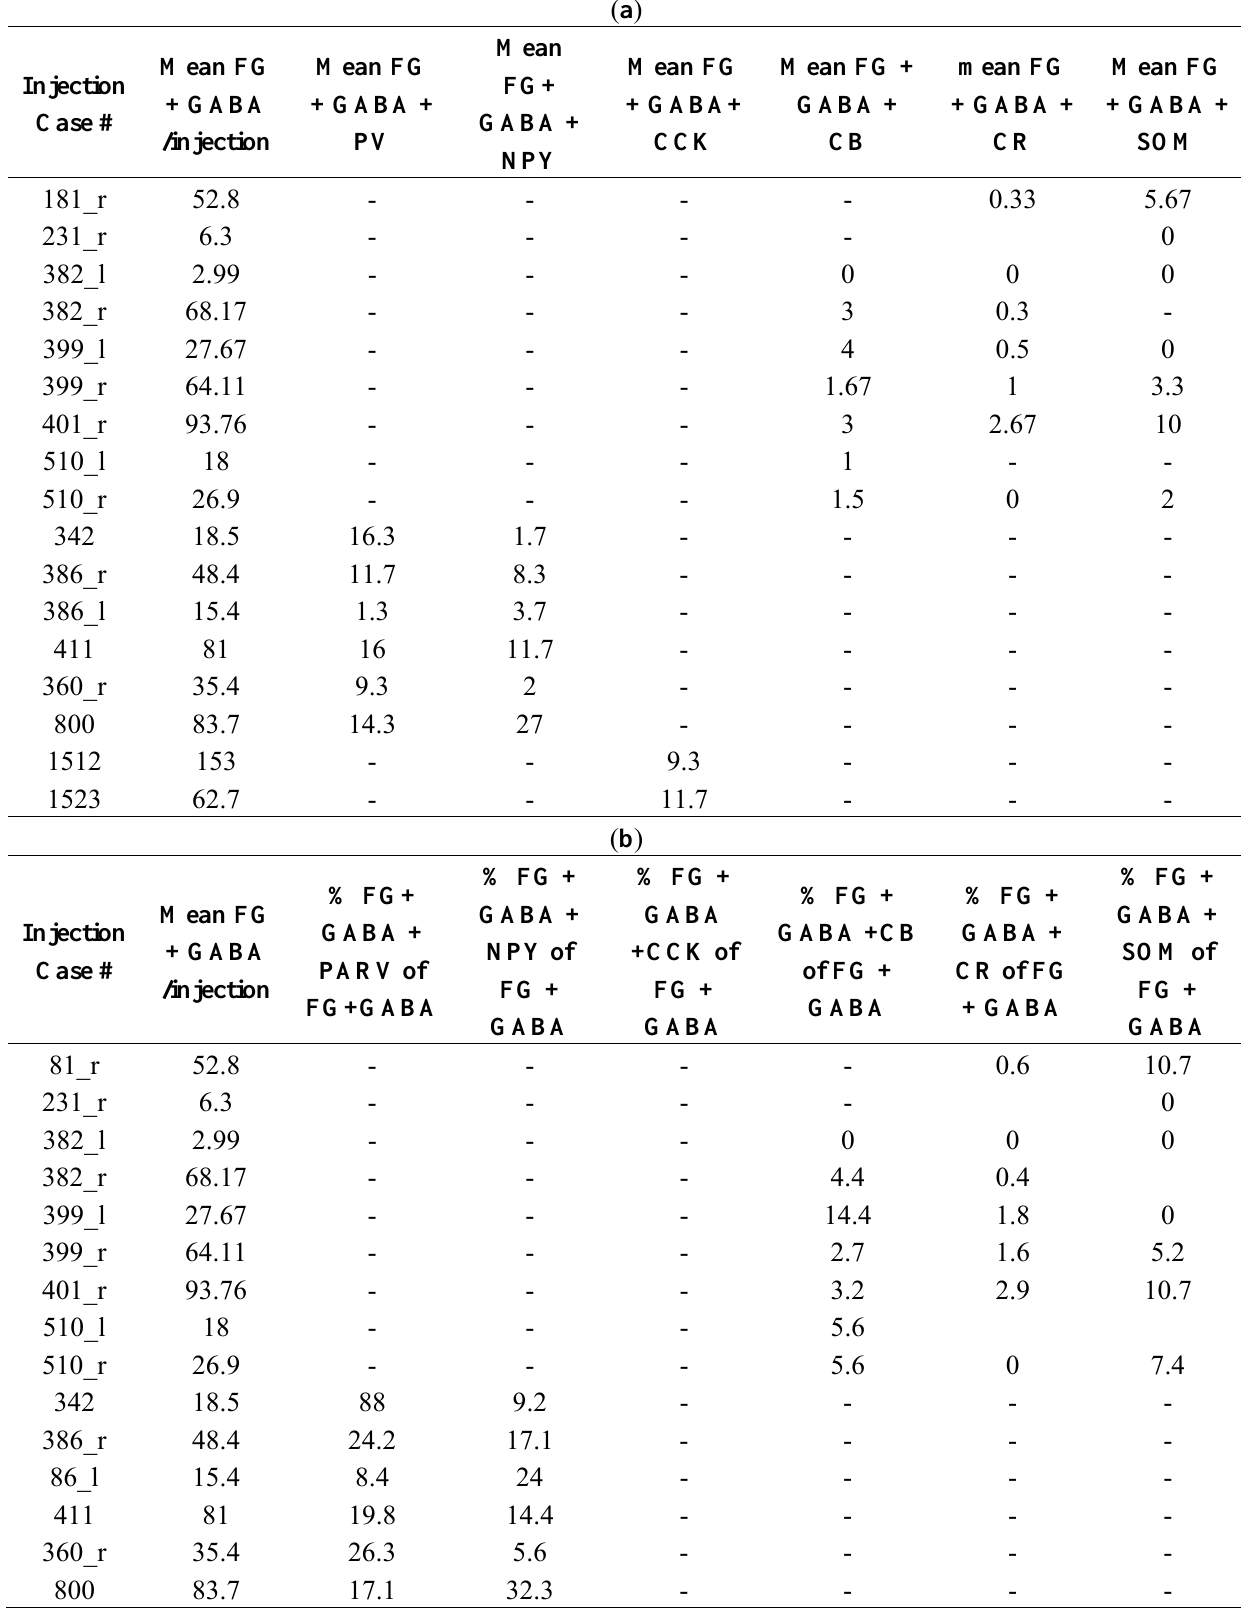
Table 4. ( a ) Mean numbers of GABAergic projection neurons that were labeled for different GABAergic markers; ( b ) percentages of GABAergic projection neurons that were labeled for different GABAergic